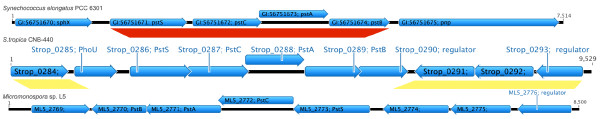
Phosphate transport (pst) operon and surrounding region in S. tropica CNB-440. Red box indicates synteny of pst between S. tropica CNB-440 and Synechococcus elongatus PCC6301. Yellow box indicates synteny between S. tropica CNB-440 and Micromonospora sp. L5. The GI numbers are listed for S. elongatus PCC6301, the locus tags are given for the S. tropica and Micromonospora genomes.